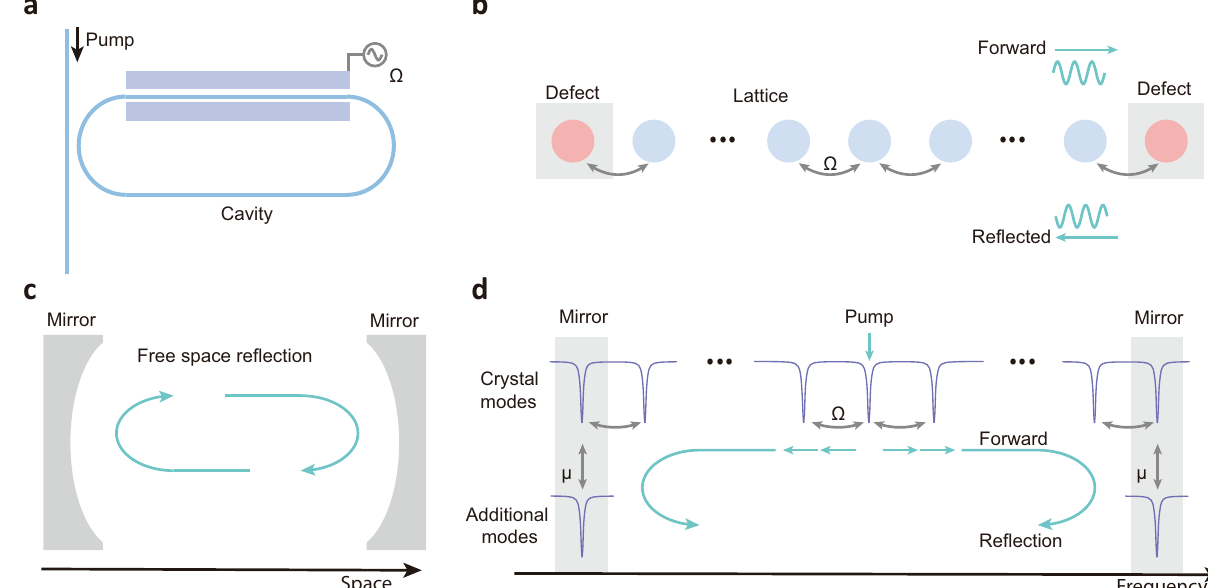
Fig. 1 | Concept of the frequency mirror and mirror-induced re fl ection in a frequency crystal. a Optical frequency crystals are generated using an optical resonator with electro-optic modulation. Microwave modulation, with frequency commensurate with the FSR of the resonator,createsnearest-neighborcoupling Ω between adjacent frequency modes of the resonator. b Defects introduced in the frequency crystalresult in re fl ections of optical signalpropagating inthe synthetic